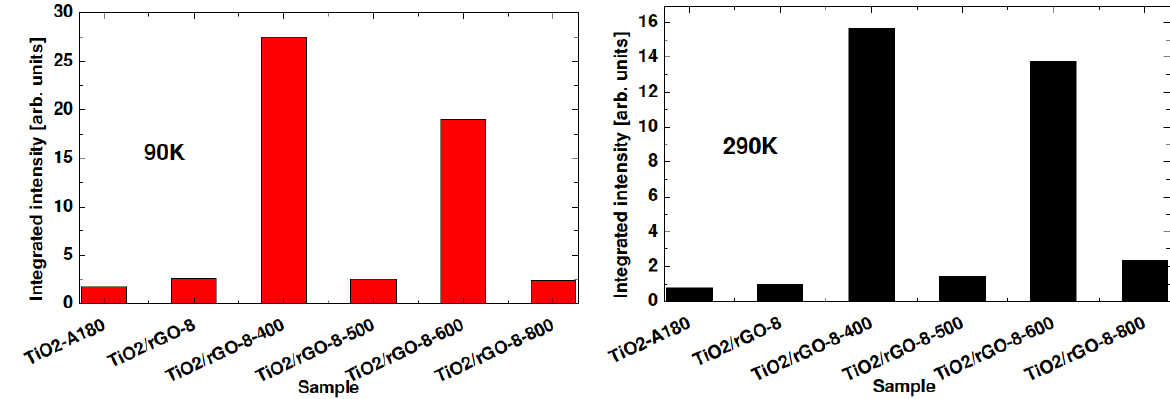
Figure 4: Integrated intensities the EPR spectra of defects arising from oxygen defects at 90 K and 290 K